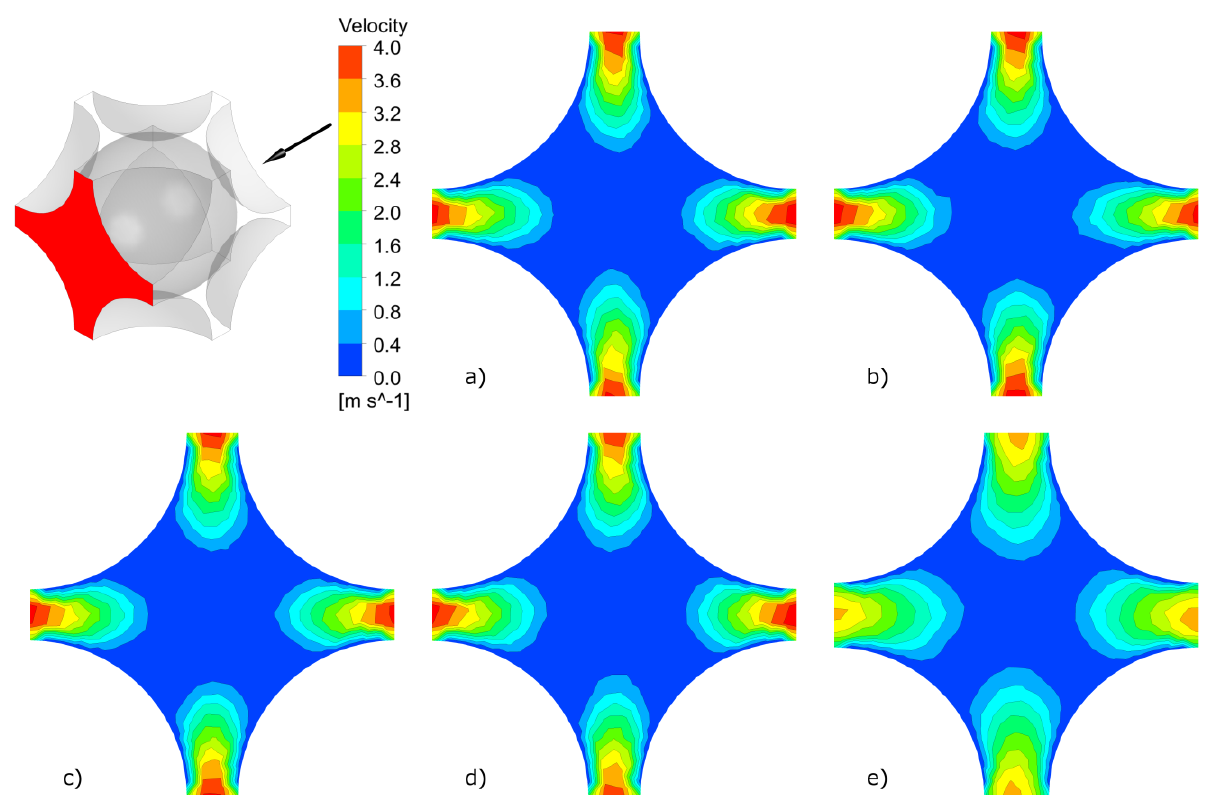
Fig. 8. Velocity magnitude on outlet surface obtained with the discretization method of granule radius reduction R g% equal: a - 99.75%. b - 99.50%. c - 99.25%. d - 99.00%. e - 95.00%.